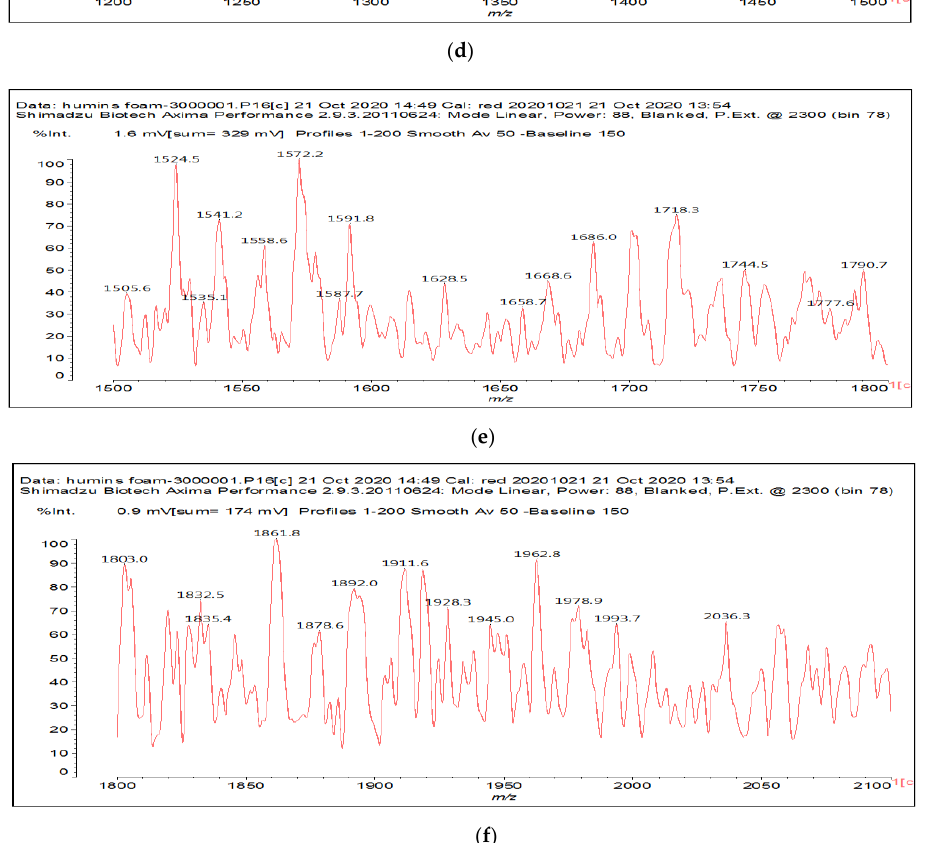
Figure 14. MALDI ToF spectrum of F-H4.5-FA6-W1.5 foams: ( a ) 300 to 600 Da range; ( b ) 600 to 900 Da range; ( c ) 900 to 1200 Da range; ( d ) 1200 to1500 Da range; ( e ) 1500 to 1800 Da range; ( f ) 1800 to 2100 Da range. Table 4. MALDI ToF analysis assignments of relevant peaks of foam F-H4.5-FA6-W1.5.